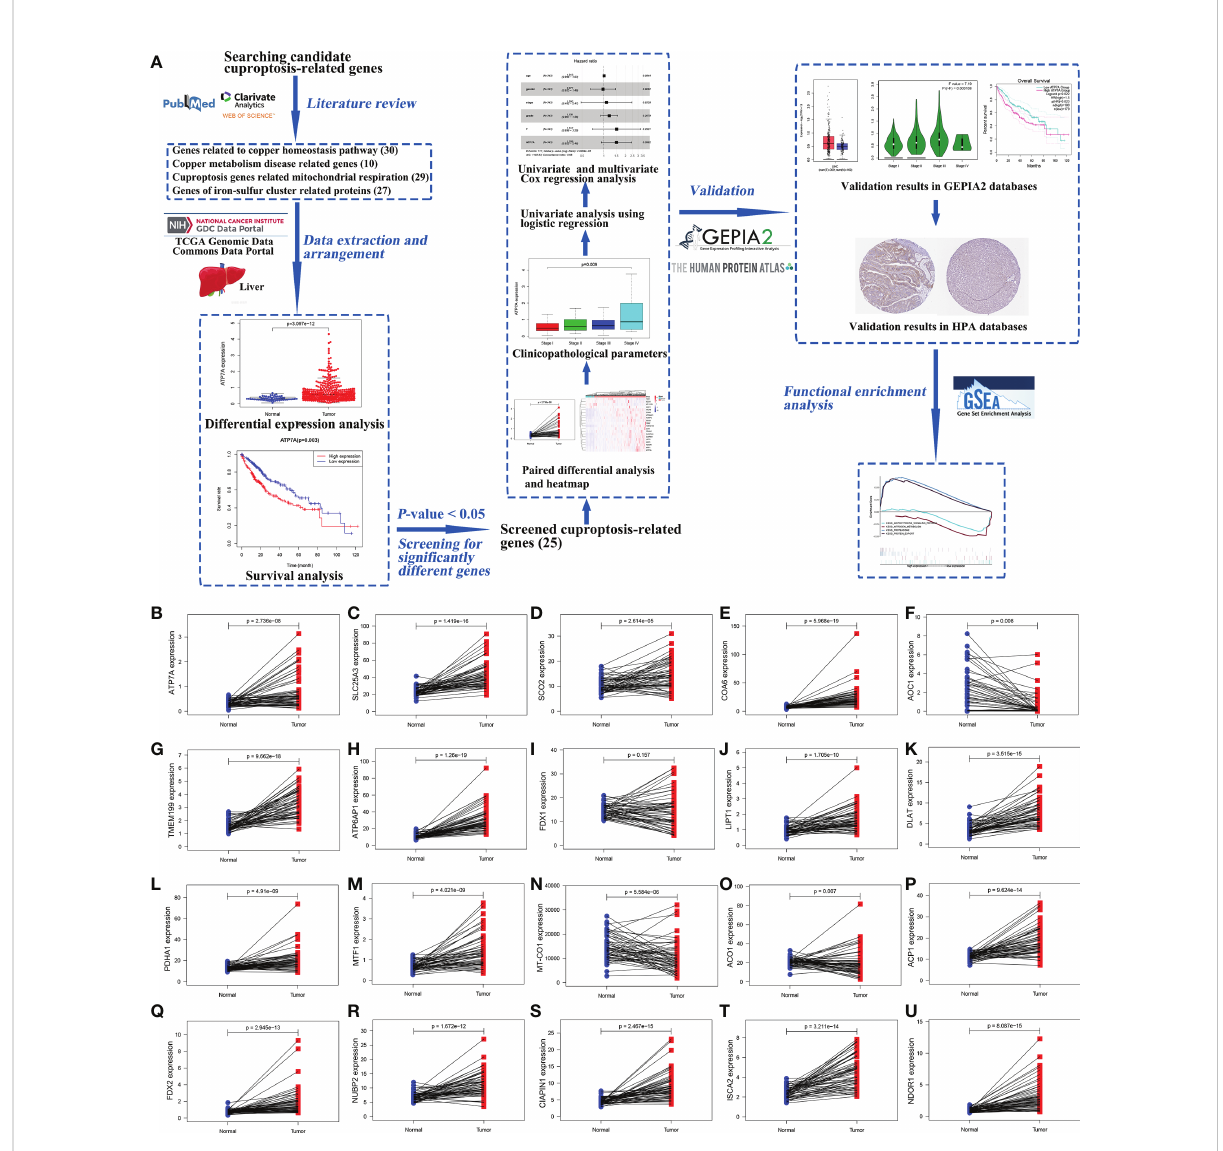
FIGURE 1 The work fl ow diagram of the study and the results of paired different expression analysis. The work fl ow diagram for exploring the expression of cuproptosis-related genes in hepatocellular carcinoma and their relationships with prognosis by bioinformatics analysis (A) . Statistical analysis of cuproptosis-related genes using Wilcoxon signed-rank test in 58 paired HCC samples and adjacent normal liver samples from TCGA data, including ATP7A (B) , SLC25A3 (C) , SCO2 (D) , COA6 (E) , AOC1 (F) , TMEM199 (G) , ATP6AP1 (H) , FDX1 (I) , LIPT1 (J) , DLAT (K) , PDHA1 (L) , MTF1 (M) , MT- CO1 (N) , ACO1 (O) , ACP1 (P) , FDX2 (Q) , NUBP2 (R) , CIAPIN1 (S) , ISCA2 (T) , and NDOR1 (U) . (ACO1, aconitase 1; ACP1, acid phosphatase 1; AOC1, amine oxidase copper containing 1; ATP6AP1, ATPase H+ transporting accessory protein 1; ATP7A, copper-transporting p-type adenosine triphosphatase 1; CIAPIN1, cytokine induced apoptosis inhibitor 1; COA6, cytochrome c oxidase assembly factor 6; DLAT, dihydrolipoamide S-acetyltransferase; FDX1, ferredoxin 1; FDX2, ferredoxin 2; GEPIA2, Gene Expression Pro fi ling Interactive Analysis 2; GSEA, Gene Set Enrichment Analysis; HCC, hepatocellular carcinoma; HPA, Human Protein Atlas; ISCA2, iron-sulfur cluster assembly 2; LIPT1, lipoyltransferase 1; MT-CO1, mitochondrially encoded cytochrome c oxidase I; MTF1, metal regulatory transcription factor 1; NDOR1, NADPH dependent di fl avin oxidoreductase 1; NUBP2, nucleotide binding protein 2; PDHA1, pyruvate dehydrogenase E1 subunit alpha 1; SCO2, synthesis of cytochrome c oxidase 2; SLC25A3, solute carrier family 25 member 3; TCGA, The Cancer Genome Atlas; TMEM199, transmembrane protein